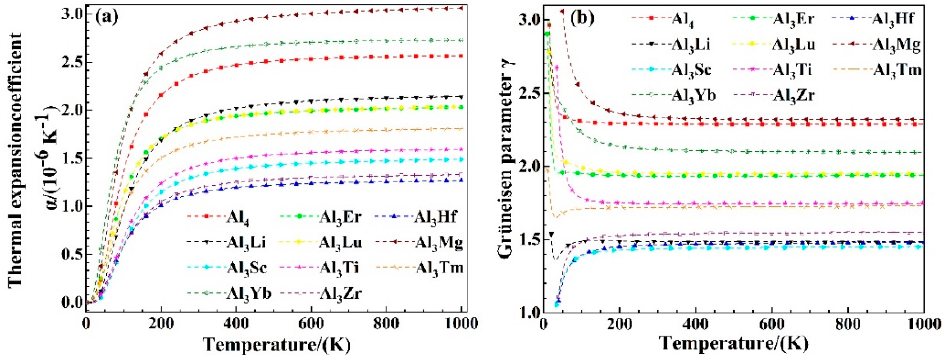
Figure 3. ( a ) Coefficient of thermal expansion α , and ( b ) Grüneisen parameter, γ for Al and L1 2 -Al 3 M phases as a function of temperature.